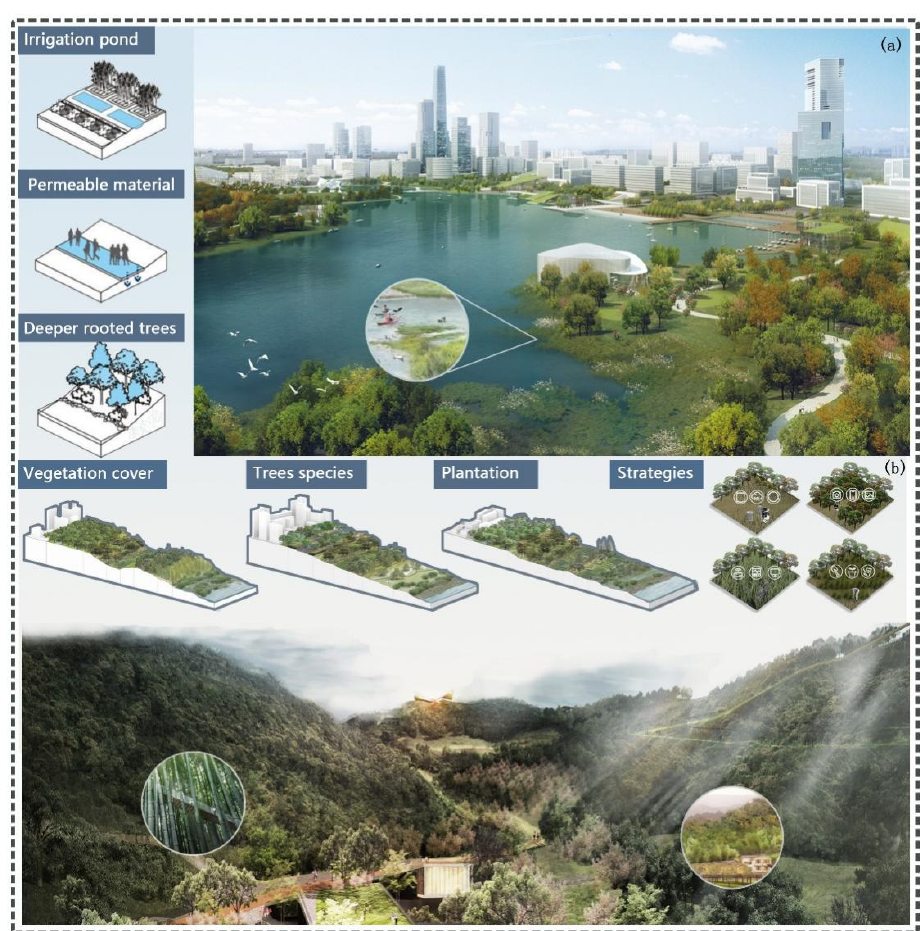
Figure 6. Landscape planning for waterscapes ( a ) and forestland ( b ) in Wuhan city,